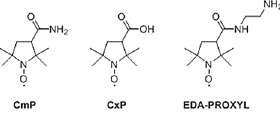
Figure 1. Chemical structures of the proxyl derivatives used in this